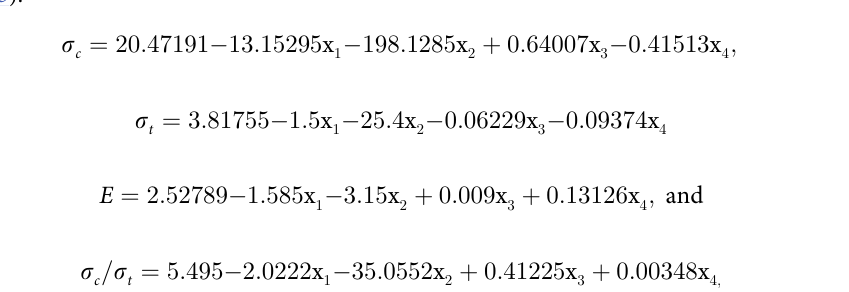
According to the test results, various mechanical parameters (uniaxial compressive strength, tensile strength, elastic modulus, compressive–tensile ratio), and influencing factors (quartz sand content, iron powder content, gypsum–cement ratio, sand particle size) were fit- ted with Origin 2021b, and a multiple linear regression equation was established using Eqs (2)–(5).